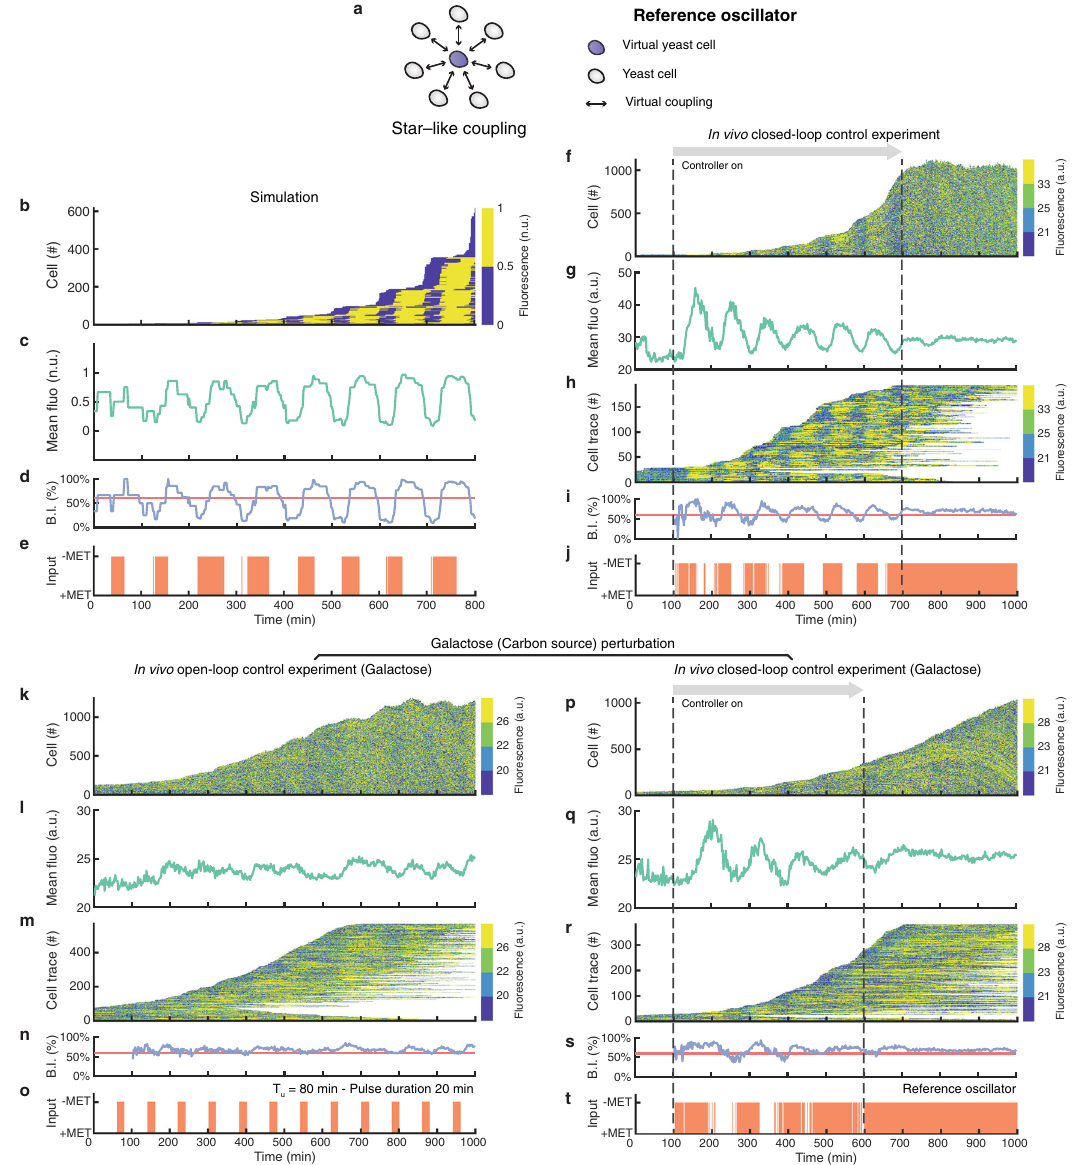
Fig. 4 Automatic feedback control enables cell cycle synchronisation of the cycling yeast strain. a Schematic illustration of the reference oscillator control strategy. Yeast cells are coupled to a virtual cell so that each cell cycles in sync with the virtual cell. b – e Numerical simulation of the reference oscillator control strategy. f – j Experimental implementation of the reference oscillator control strategy. An initial calibration phase of 100 min is required to set up the phase estimation algorithm. Dashed lines indicate the start and the end of the control experiment, after which cells are grown in methionine- depleted medium. k – o Open-loop experiment subjecting cells to alternating pulses of methionine-rich ( + MET) and methionine-depleted ( − MET) medium with a period T u = 80 min using galactose (2% w/v) as carbon source. p – t Experimental implementation of the reference oscillator control strategy using galactose (2% w/v) as carbon source. b , f , k , p The number of cells and the distribution of YFP fl uorescence intensity in the population over time. Fluorescence values are binned into 4 colours, corresponding to the quartiles, for clarity of visualisation. c , g , l , q Average YFP fl uorescence intensity in the cell population. h , m , r Single-cell fl uorescence traces over time. Each horizontal line corresponds to one cell. Each line starts when the cell is fi rst detected and ends when the cell exits the fi eld of view. The number of tracked cells does not correspond to the total number of cells as only cells tracked for longer than 300 min are shown. d , i , n , s Budding index (blue) reporting the percentage of cells in the budding phase (S-G 2 -M) computed from estimated cell cycle phases. Red line denotes the expected value of the budding index in the case of a totally desynchronised cell population. e , j , o , t Growth medium delivered to the cells as a function of time: + MET methionine-rich medium, − MET: methionine-depleted